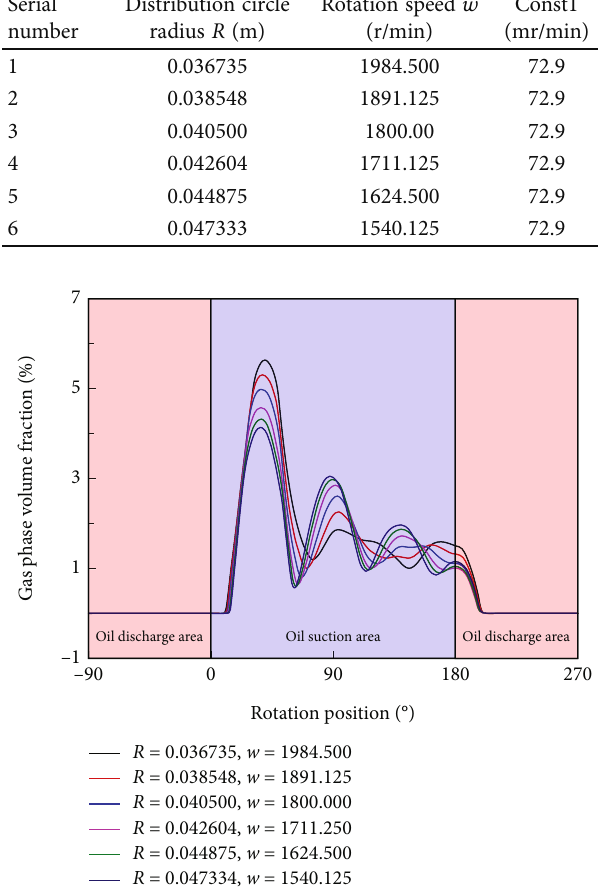
Figure 13: The gas phase volume fraction curves in the plunger chamber with di ff erent distribution circle radii and rotation